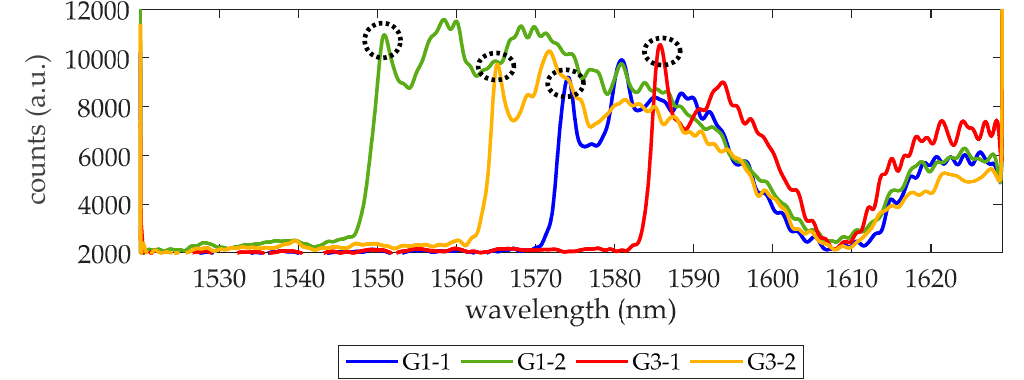
Figure 2. Transmission spectra of the four PC structures being monitored. The circles indicate the photonic band gap (PBG) edge, where a local maximum transmission is observed. The wavelength position of such maximum is tracked to know how the PBG edge shifts during biosensing experiments. Counts refer to the digital values provided by the 14-bit analog to digital converter (ADC) of the infrared (IR) camera. The dip around 1608 nm indicates the minimum for the response of the access grating couplers.